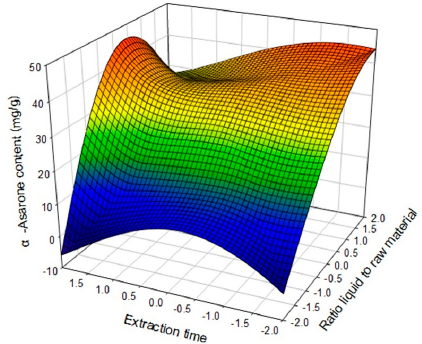
Figure 2. Response surface plot for the effects of ratio of liquid to raw material (X 1 ) and extraction time